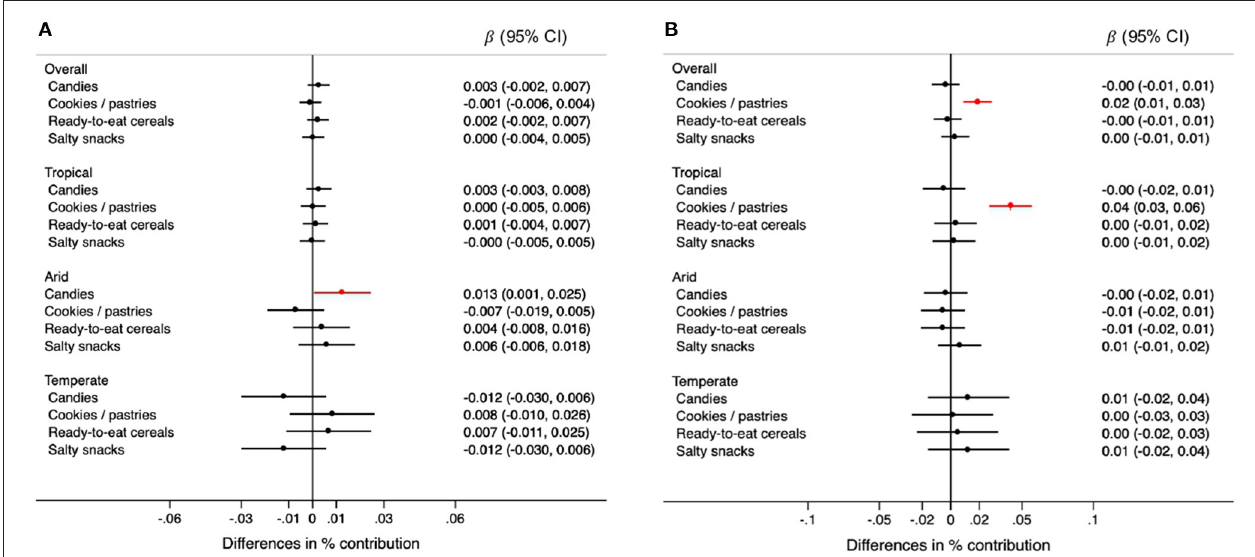
FIGURE 6 | Differences in the percentage (95% CIs) of contribution of types of high-energy ultra-processed foods to the total energy intake for each 0.5mm annual decrease in rainfall (A) and for each 0.1 ◦ C annual increase in temperature (B) during the 5-year period prior to the survey, overall and by climate region. Values were obtained using multivariable multilevel linear regression models adjusted for climate region (overall models) sex, age group, educational level, and rainfall or temperature, as